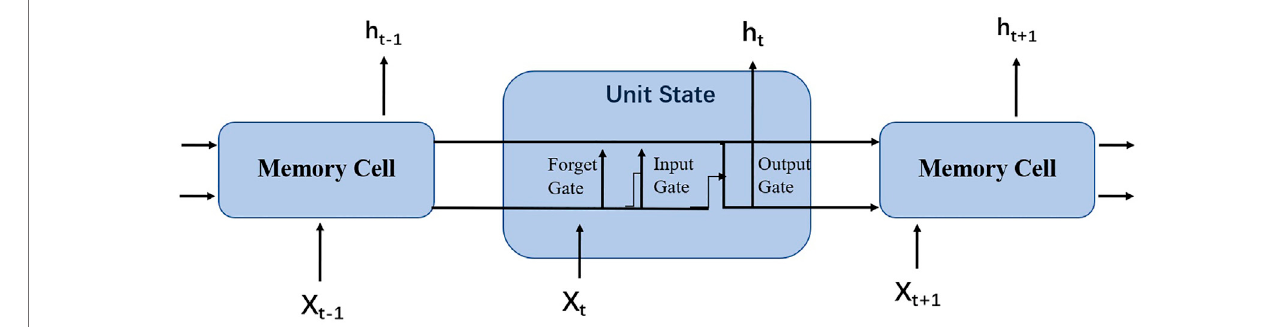
FIGURE 1 | LSTM gate structure.